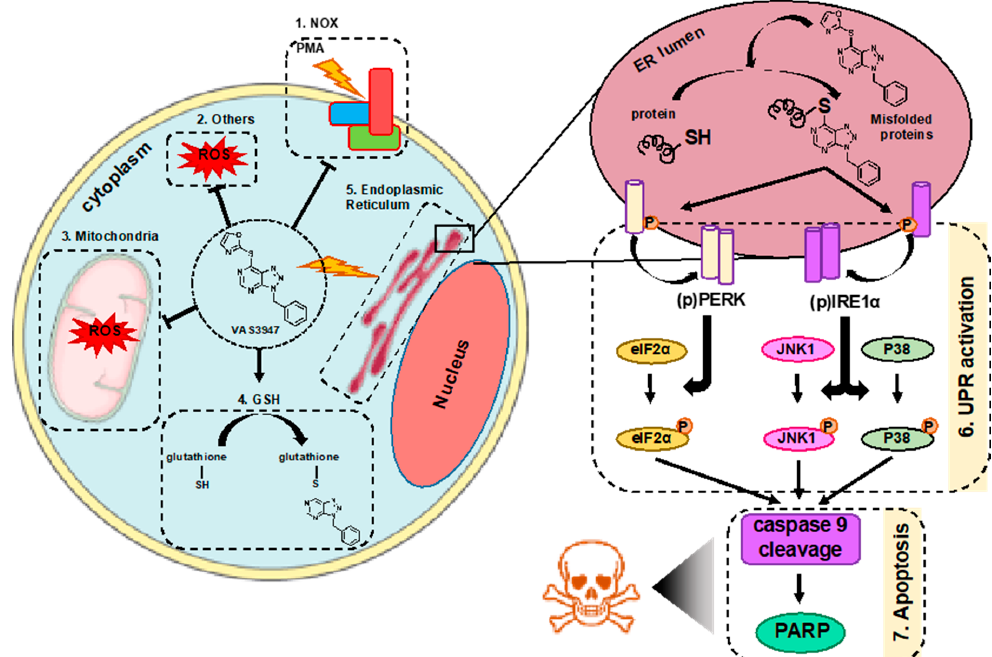
Figure 9. Schematic representation of the e ff ect of VAS3947 on AML cell lines. In AML cell lines, beside its e ff ect as an inhibitor of NOX-derived ROS production (1), VAS3947 has other o ff -target e ff ects. VAS3947 induces NOX independent cytoplasmic ROS decrease (2) as well as mitochondrial ROS production (3) by a yet unclear mechanism. Moreover, it e ffi ciently thiol alkylates cysteine residues of GSH, leading to its cellular depletion (4) and aggregates with intracellular proteins leading to endoplasmic reticulum (ER) stress (5). The latter causes accumulation of proteins in the ER lumen, thus triggering the UPR activation via the phosphorylation and dimerization of PERK and IRE1 α (6). This leads to the activation of eIF2 α , JNK1, and P38MAPK, through their phosphorylation, and results in apoptosis via the cleavage of caspases, such as caspase 9, and consequently PARP (7). Glutathione is a major contributor to the antioxidant system. The pool of reduced GSH is